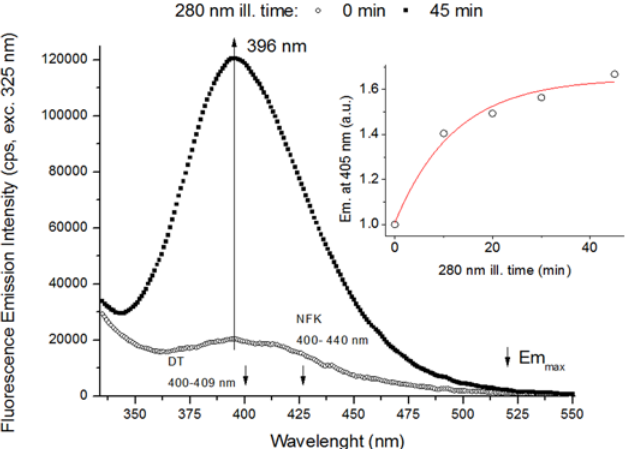
Fig 7. Fluorescence emission of human plasminogen (325 nm excitation). Fluorescence emission spectra (325 nm exc.) recorded before and after 280 nm light continuous illumination (45 min) of human plasminogen in solution. There is an increase in emission intensity at 396 nm with 280 nm ill time. Small decreasing arrows indicate the wavelengths of maximum emission intensity (Em max ) of DT and NFK in solution. Insert - Fluorescence emission intensity at 405 nm (exc. 325 nm) vs 280 nm illumination time. The experimental points were fitted to an exponential function F(t) = C 1 – C 2.e - kt . Fitted parameter values and corresponding errors, and root mean square error values were obtained after fitting the kinetic trace (Table